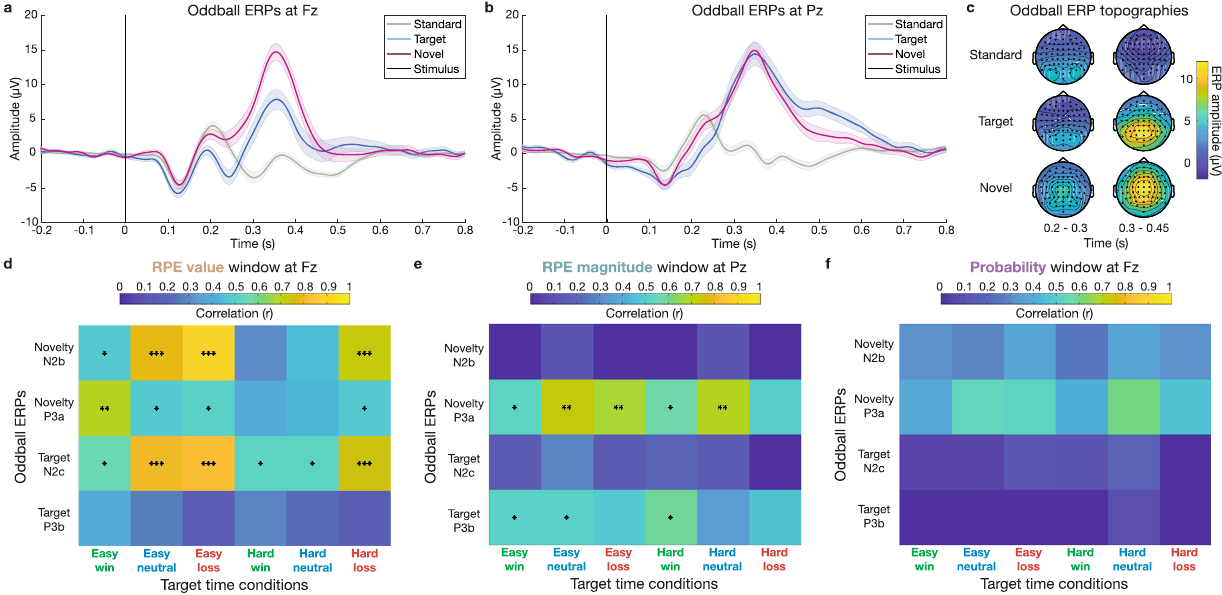
Fig. 5 ERP comparison between Target Time feedback and 3-tone Oddball tasks. a Stimulus-locked grand-average Oddball ERPs at Fz plotted for each condition, with shaded error bars indicating standard error of the mean across 22 participants. N2 is evident ~250 ms in target and to a lesser extent in novel conditions. b Same for Pz. P3 is evident at ~350 ms in target and novel conditions. c Spatial topographies of grand-average ERPs averaged during N2 (200 – 300 ms) and P3 (300-450 ms) windows. Note the posterior distribution of the Target P3b and central distribution of the Novel P3a. d Correlation matrix between N2 and P3 ERPs in Oddball task and mean amplitude of 50 ms window centered on maximal RPE value effect at Fz in Target Time conditions. Asterisks indicate signi fi cance at q FDR < 0.05 (*), q FDR < 0.01 (**), and q FDR < 0.001 (***) across 22 participants. Note strong correlation between Oddball N2s and Target Time conditions with negative valence, especially for the Oddball Target N2c. e Same but correlating N2 and P3 amplitudes from Oddball task with mean amplitude of 50 ms window centered on maximal RPE magnitude effect at Pz in Target Time conditions. f Same but correlating N2 and P3 amplitudes from Oddball task with mean amplitude of 50 ms window centered on maximal probability effect at Fz in Target Time